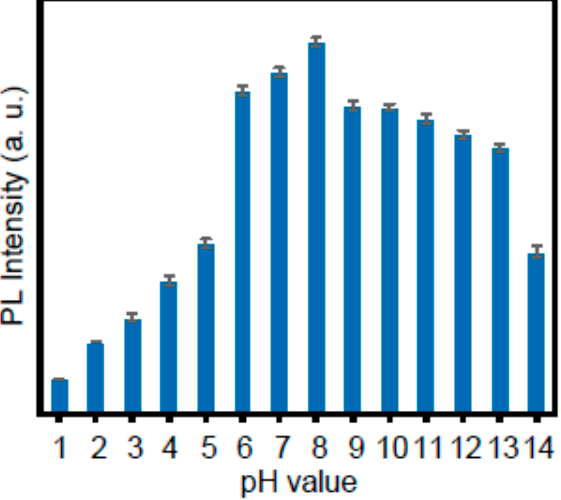
Figure 4. Fluorescence intensity of N − GQDs at different